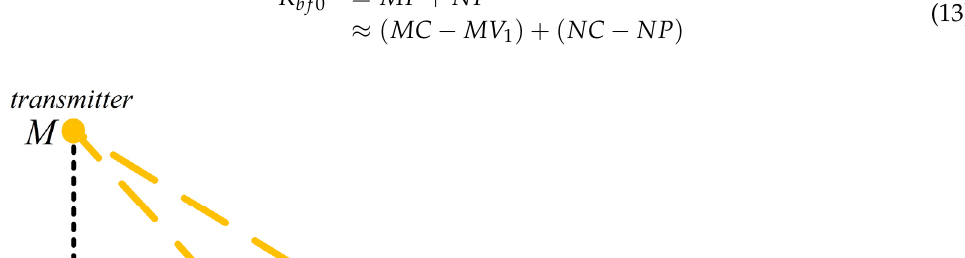
MV and NV can be approximated as MP and NP , respectively. MP and NP 1 2